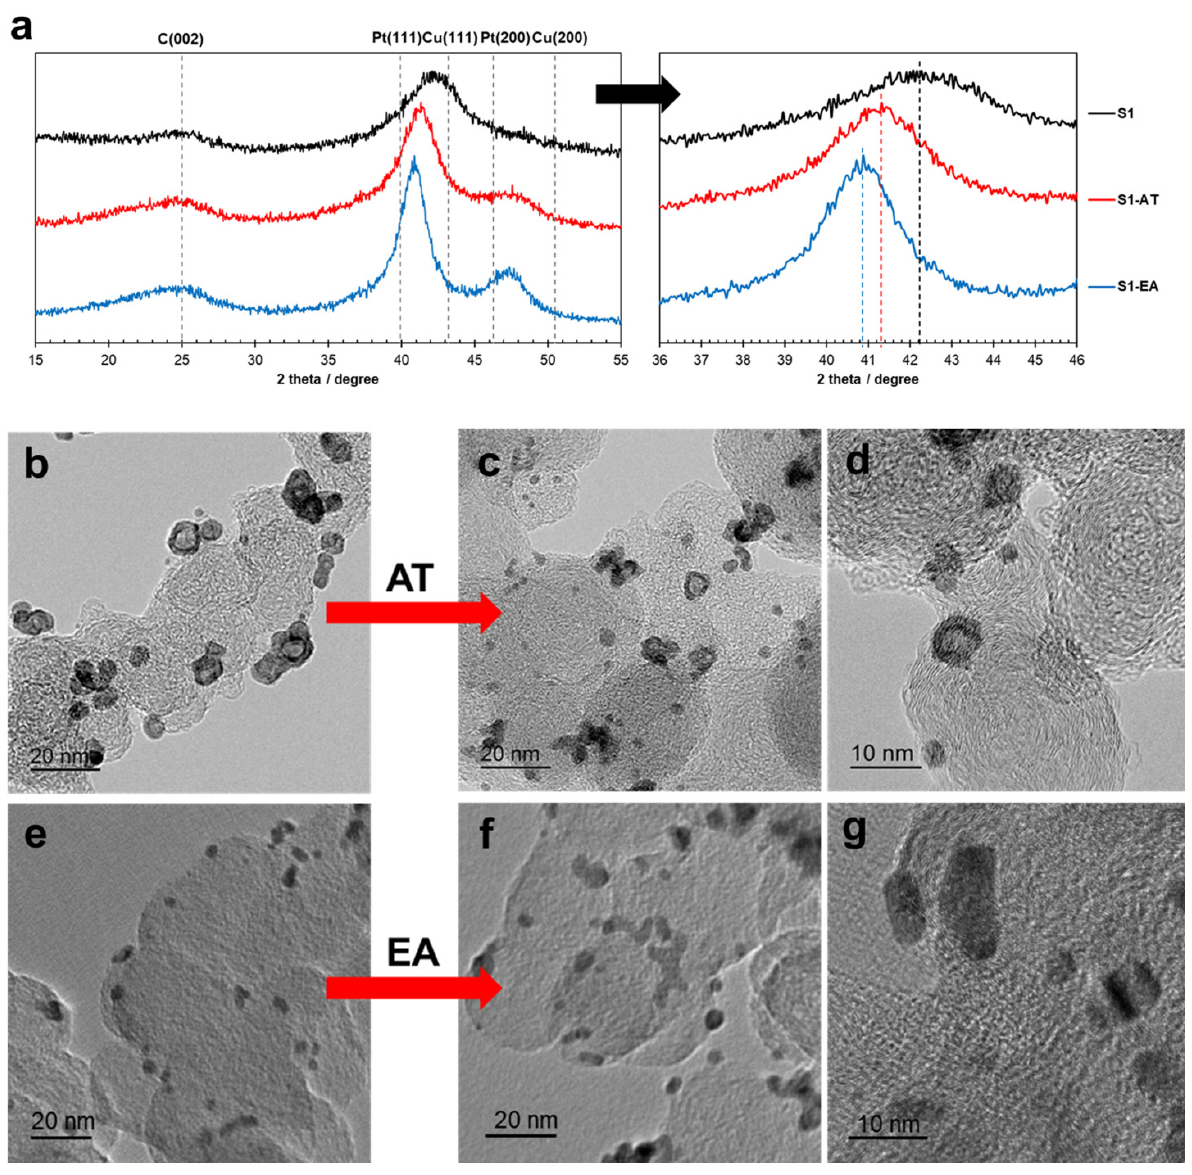
Figure 3. X-ray diffraction ( XRD) patterns of PtCu/C materials with alloy structure of NPs ( a ): initial, after acid treatment and after electrochemical activation. TEM images of PtCu/C catalysts with core–shell ( b – d ) and alloy ( e – g ) structure: initial ( b , e ) and after acid ( c , d ) and electrochemical ( f , g ) de- alloying, respectively.